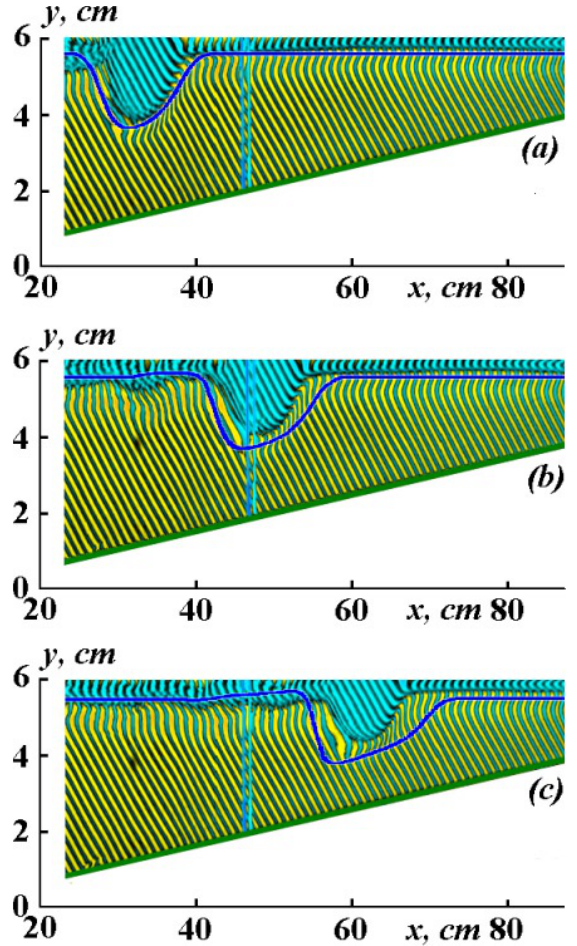
Fig. 6. Shoaling solitary wave (tan α = 0 . 05). Photos of experiment II (background) taken through the time interval 10s are compared with numerical calculations by (1). The lower part of the experi- mental installation (Fig. 1c, 0 ≤ y ≤ H ) is